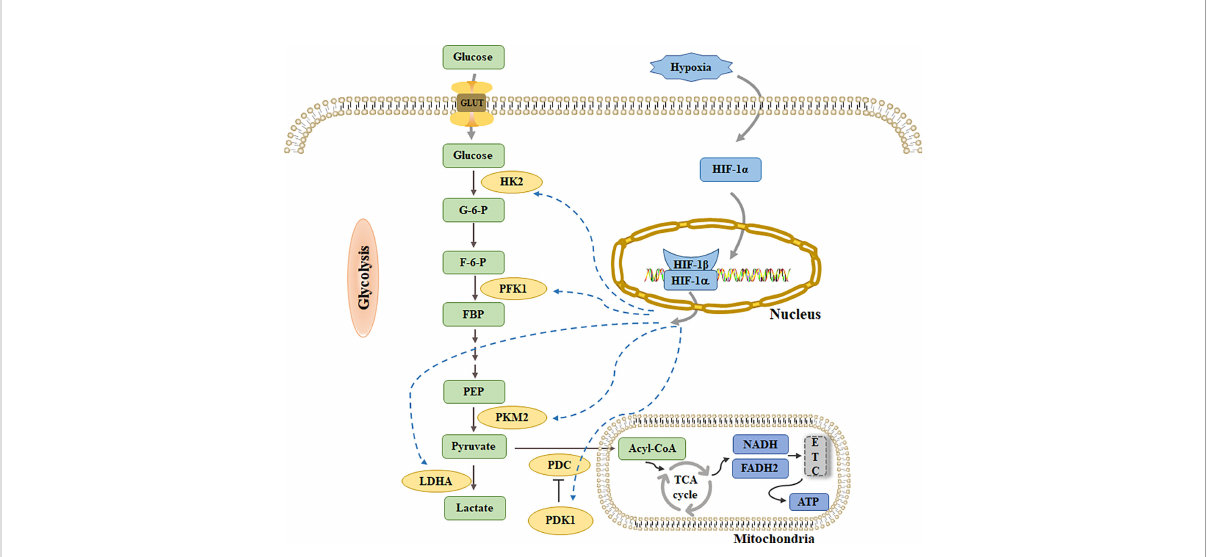
FIGURE 2 Glucose transport into cells through GLUT and decompose into pyruvate by a series of glycolytic enzymes such as HK2, PFK1 and PKM2. PDC catalyzes the conversion of pyruvate into acetyl-CoA, enters TCA cycle, generates NADH and FADH2, and then enters ETC to produce ATP. Under hypoxia, pyruvate is activated by LDHA to generate lactate. HIF-1 a can increase glycolysis fl ux by up-regulating HK2, PFK1 and PKM2. At the same time, increasing the levels of PDK1 and LDHA inhibited pyruvate from entering TCA